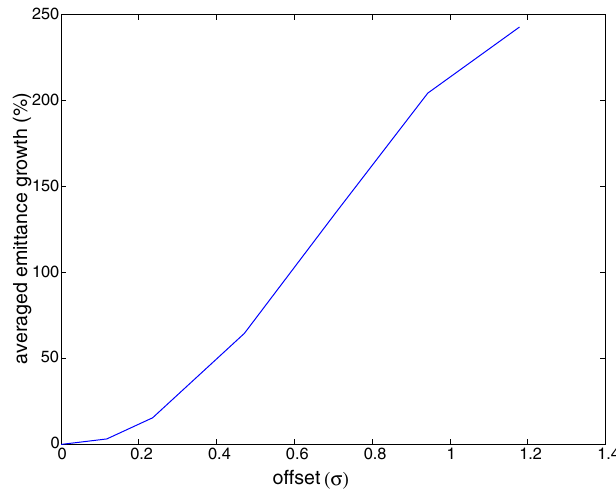
FIG. 12. (Color) Emittance growth at the end of the injector as a function of initial misalignment of the beam.